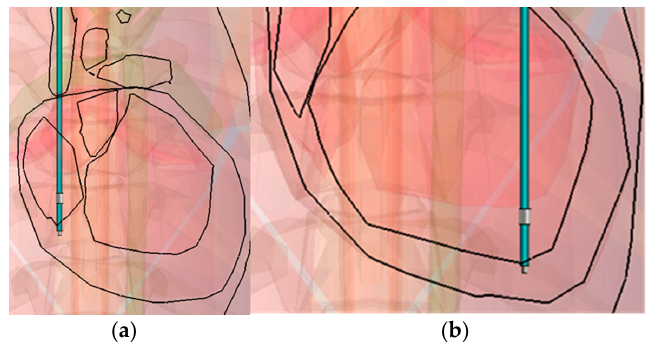
Figure 6. Tip implantation in the Right Atrium ( a ); and the Right Ventricle ( b ), both cases for the bottom implantation position of the chamber concerned in coronal view. Table 7. Comparison between the right ventricle and atrium implantation, concerning the induced